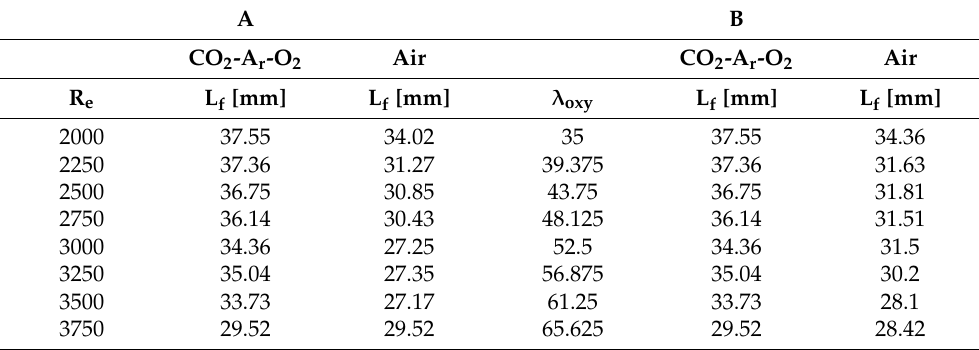
. V CH4 = 1 L/min) and (B: λ oxy = [ 35 − 65.625 ]